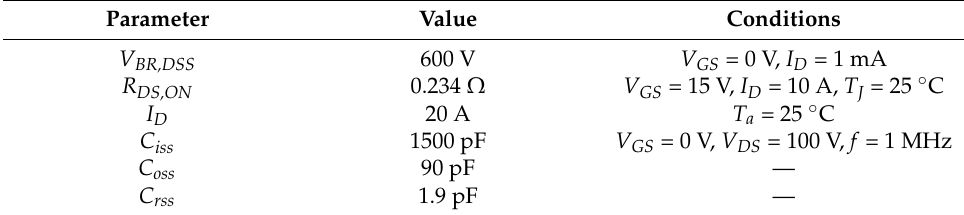
Table 3. Main super junction MOSFET